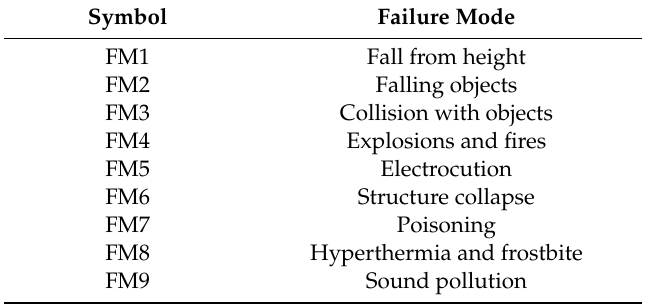
Table 2. Potential failure modes (Occupational hazards in the construction industry).